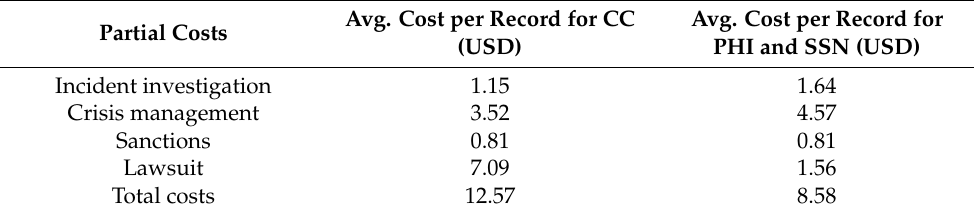
Table 1. Average cost/record for two record types in hub international calculator by our analysis. Partial